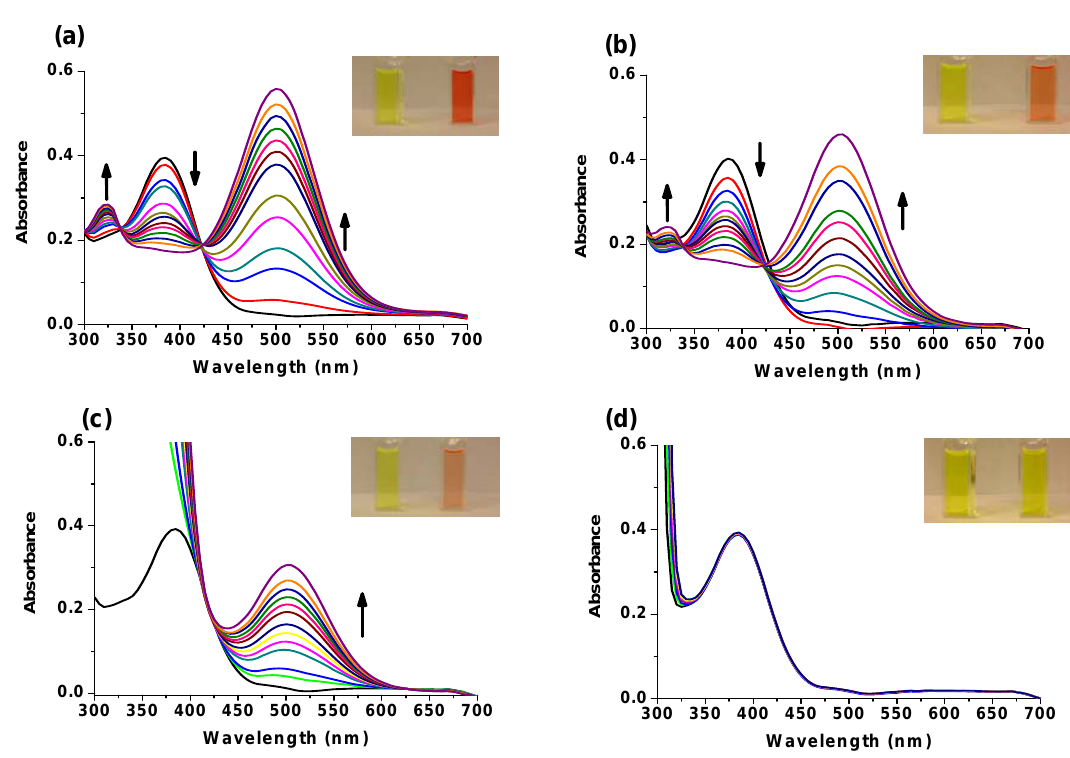
Figure 13. Changes in UV-visible absorbance of DQA upon binding to OP